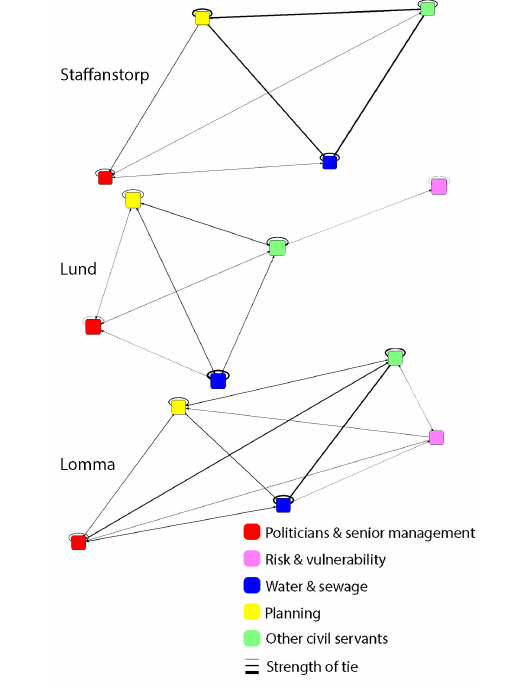
Fig. 1 . Networks of types of actors mitigating flood risk within the three studied municipal administrations. Note that node sizes are set, while tie thicknesses represent the sum of individual ties and are relative within each network and cannot be compared between